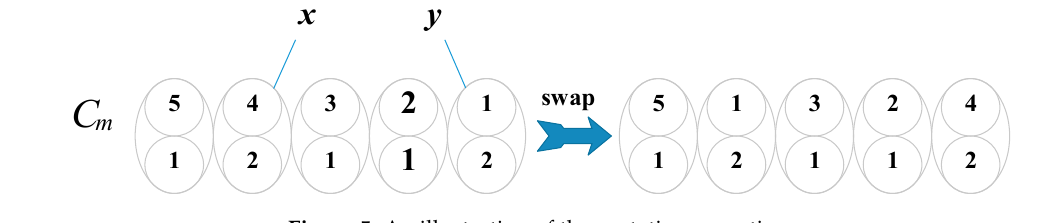
Figure 5. An illustration of the mutation operation. Algorithm 5. Algorithm for mutating a